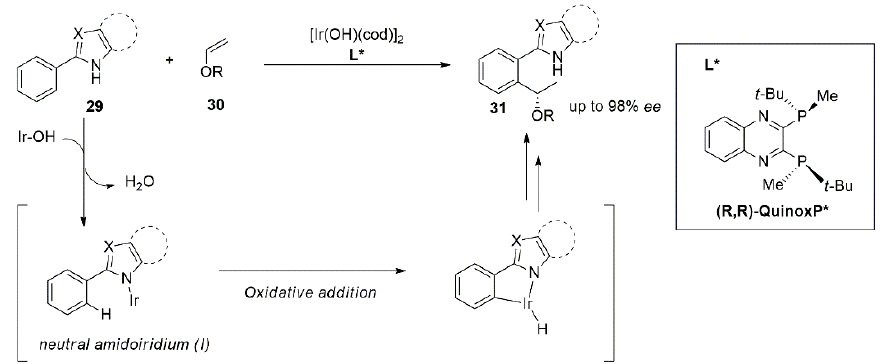
Figure 18. Asymmetric hydroarylation of vinyl ethers ( 30 ) catalyzed by a hydroxoiridium complex with (R,R)-QuinoxP.